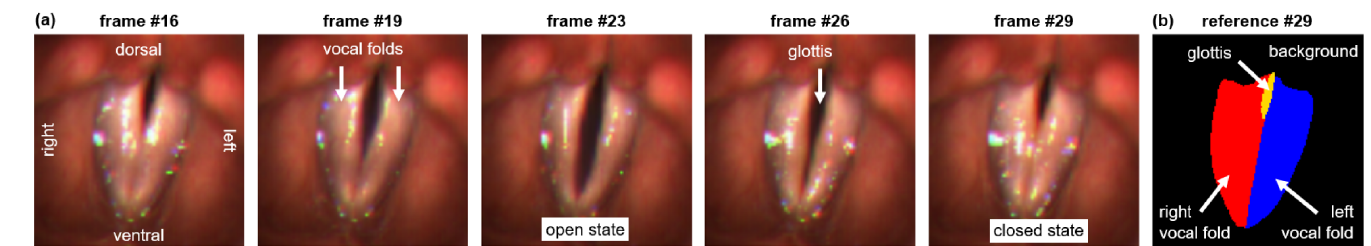
Fig 1. Laryngeal high-speed video data. (a) Frames from a single oscillation cycle of a healthy female subject (26 yrs, F 0 = 215 Hz). (b) Reference segmentation for the last frame (#